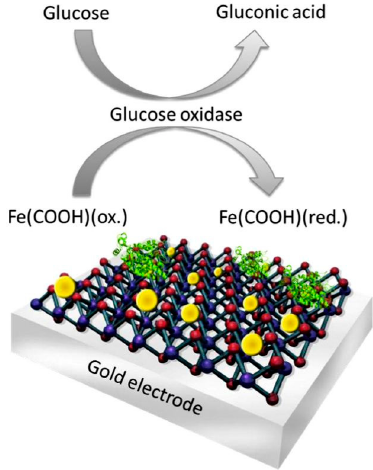
Figure 7. Schematic diagram of Au nanoparticle-structuring on a MoS 2 nanosheet [29].